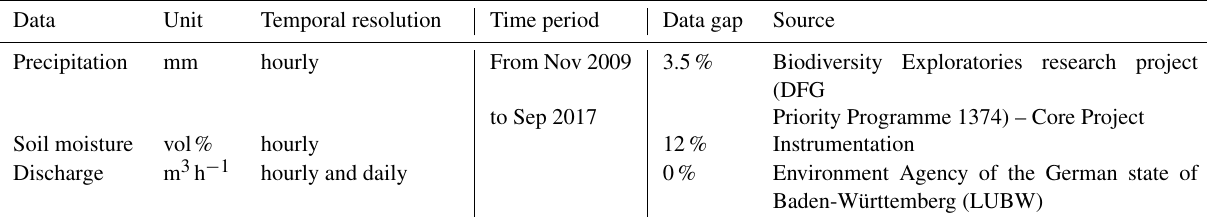
Table 1. Dataset description.